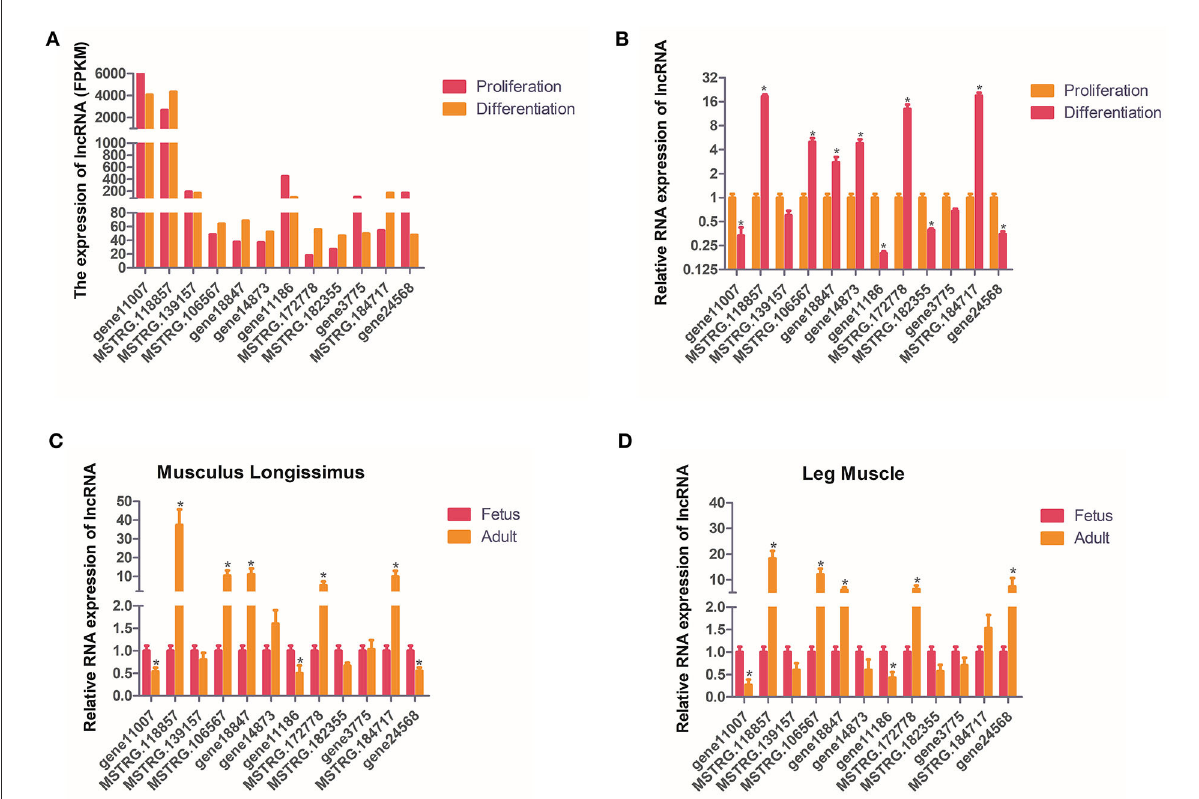
FIGURE5 Validation of putative lncRNAs. (A,B) 12 candidate lncRNAs were selected and identified using quantitative real-time PCR. (C,D) 12 candidate lncRNAs were identified in fetal and adult buffalo leg muscles and musculus longissimus using qPCR. The values are means ± SEMs for three individuals. *represents P <